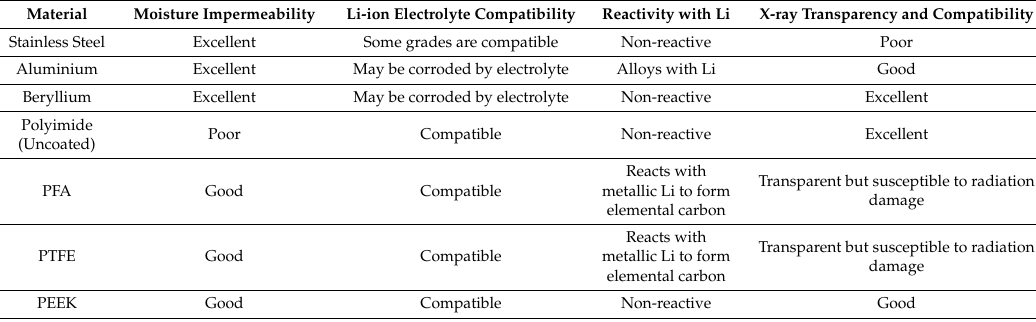
Table 1. Comparison of common materials used in construction of Swagelok-type